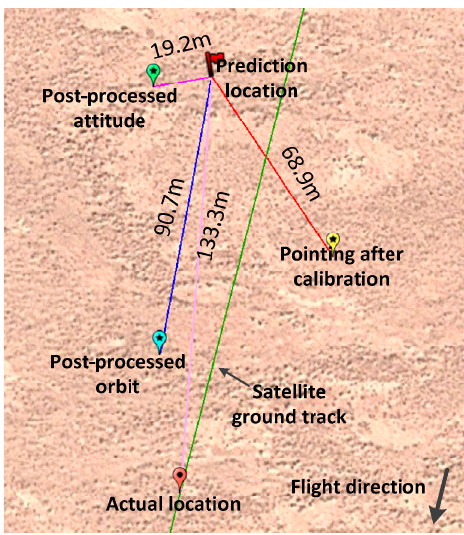
Figure 15. Decomposition of prediction errors.